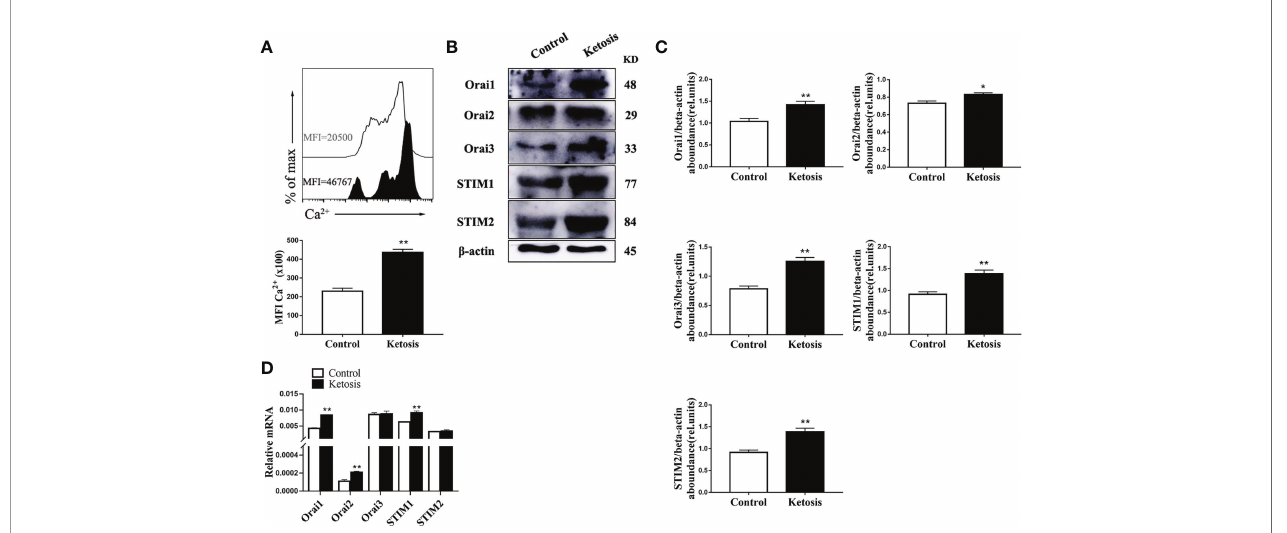
FIGURE 2 | Ketosis increased the levels of Ca 2+ and expression of SOCE. (A) Staining of intracellular Ca 2+ using Fluo-3A (n = 4 per group). (B) Western blot analysis of SOCE-related protein (n = 6 per group) (C) Relative protein abundance of SOCE (n = 6 per group). (D) ORAI and STIM mRNA expression were measured by qRT-PCR (n = 6 per group). For all bar plots shown, data are expressed as the means ± SEM, *P < 0.05, **P < 0.01 by independent-samples